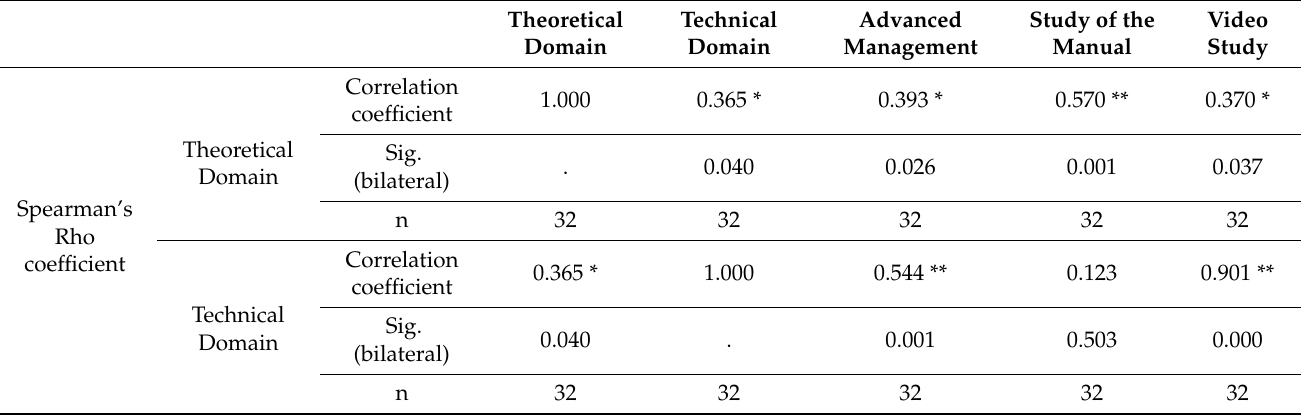
Table 6. Correlations between simulator knowledge/learning variables and resources. Teachers